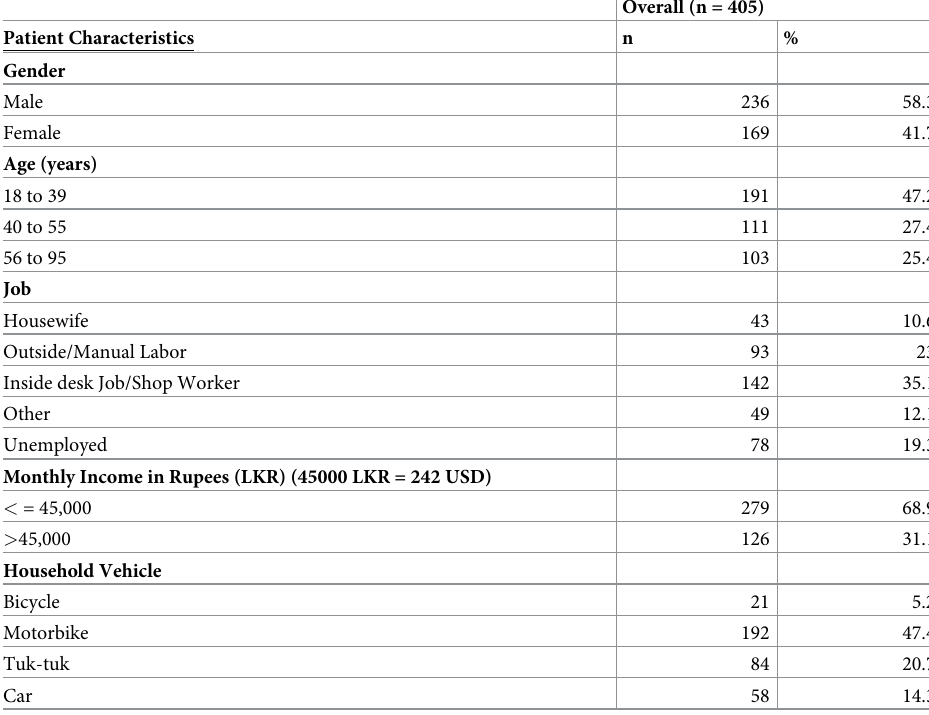
Table 1. Patient characteristics: Frequencies and